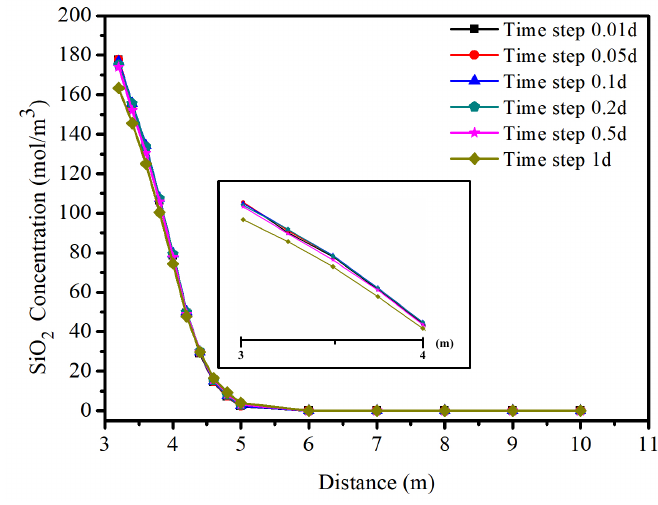
Figure 4. The influence of the time step on the UPM results.